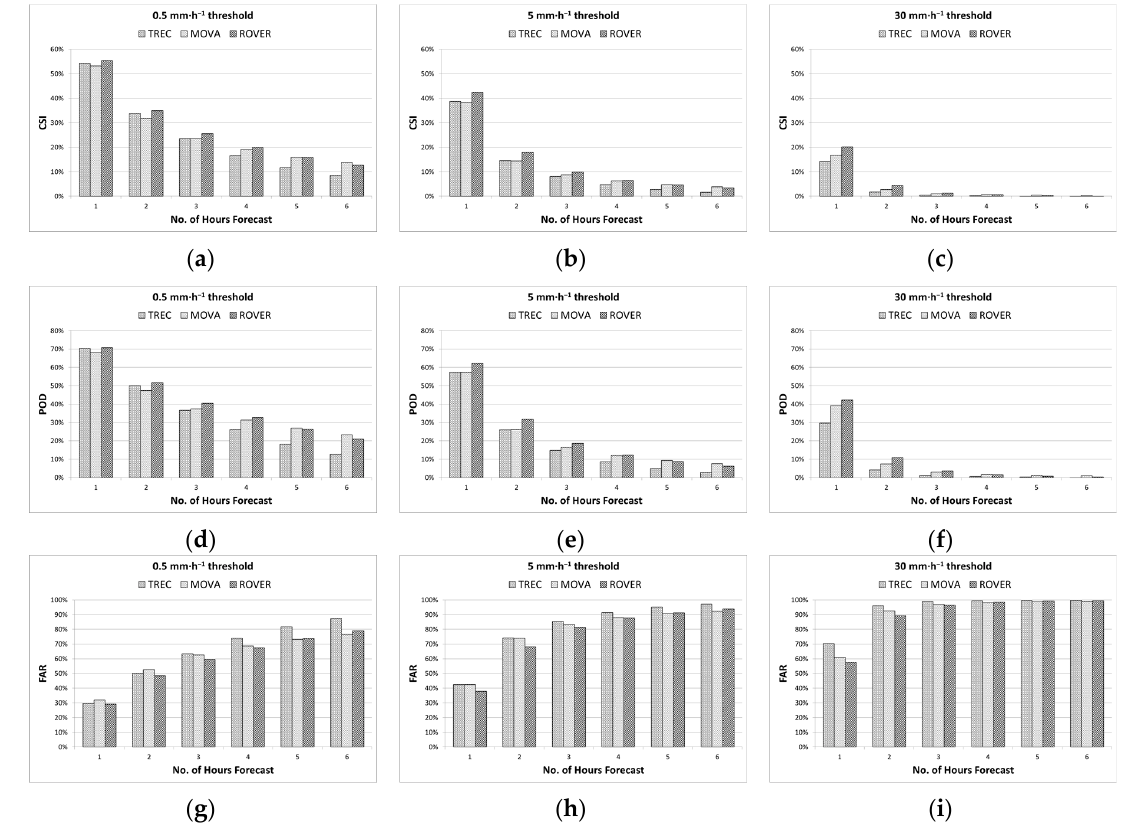
Figure 8. A comparison of the performance of various radar echo tracking algorithms at various thresholds in 1–6 h forecasts ( x -axis). ( a ) CSI at 0.5 mm·h − 1 threshold; ( b ) CSI at 5 mm·h − 1 threshold; ( c ) CSI at 30 mm·h − 1 threshold; ( d ) POD at 0.5 mm·h − 1 threshold; ( e ) POD at 5 mm·h − 1 threshold; ( f )